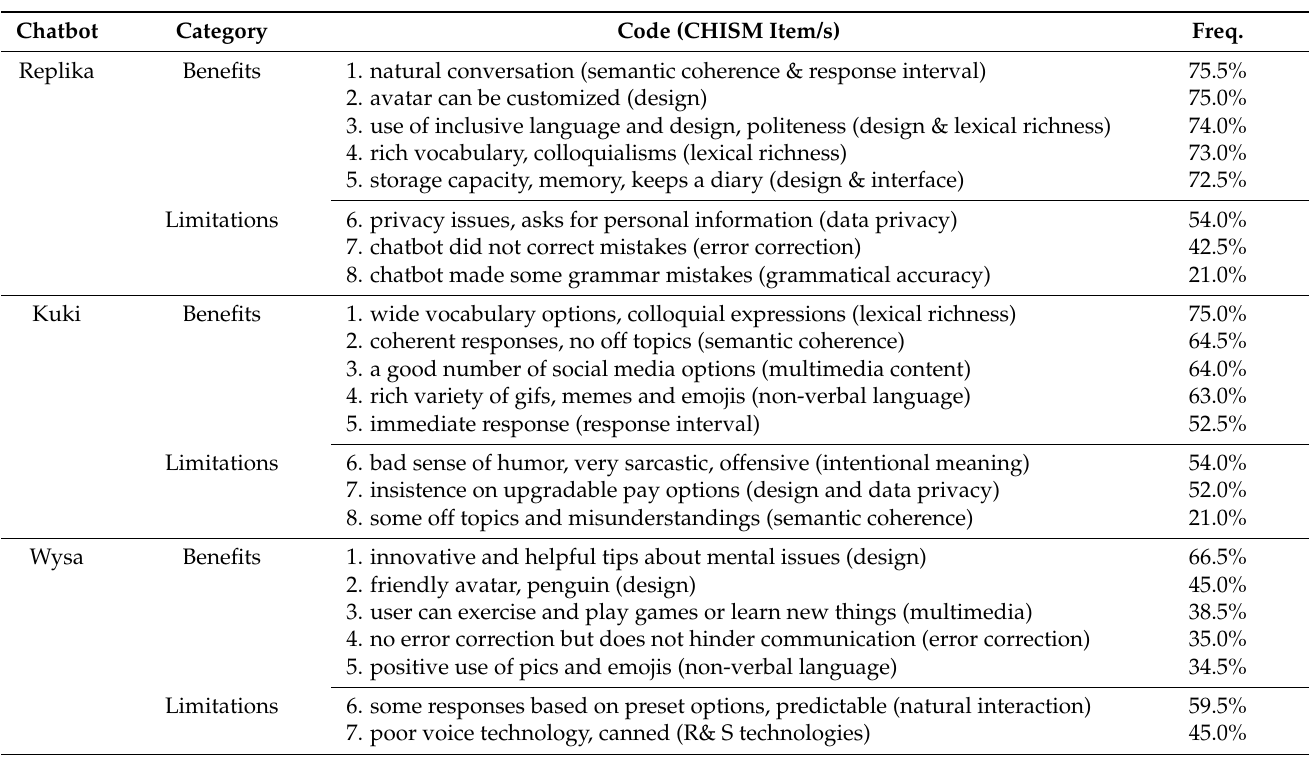
Table 9. Benefits and limitations of each conversational agent (code